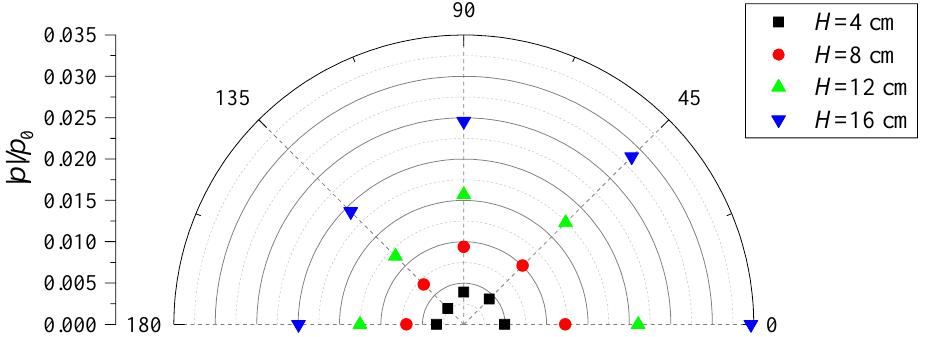
Figure 15. Distribution of the maximum pore-water pressures around the pile for various wave heights at z = − 0.15 m ( T = 2 s, Points 12, 14, 15, 16, and